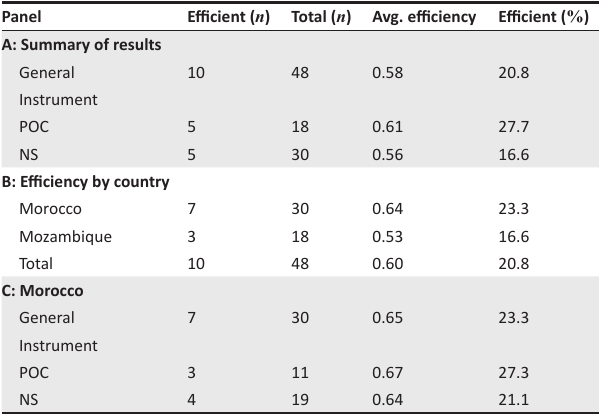
TABLE 6: Instrument efficiency without extreme values: General model. Panel